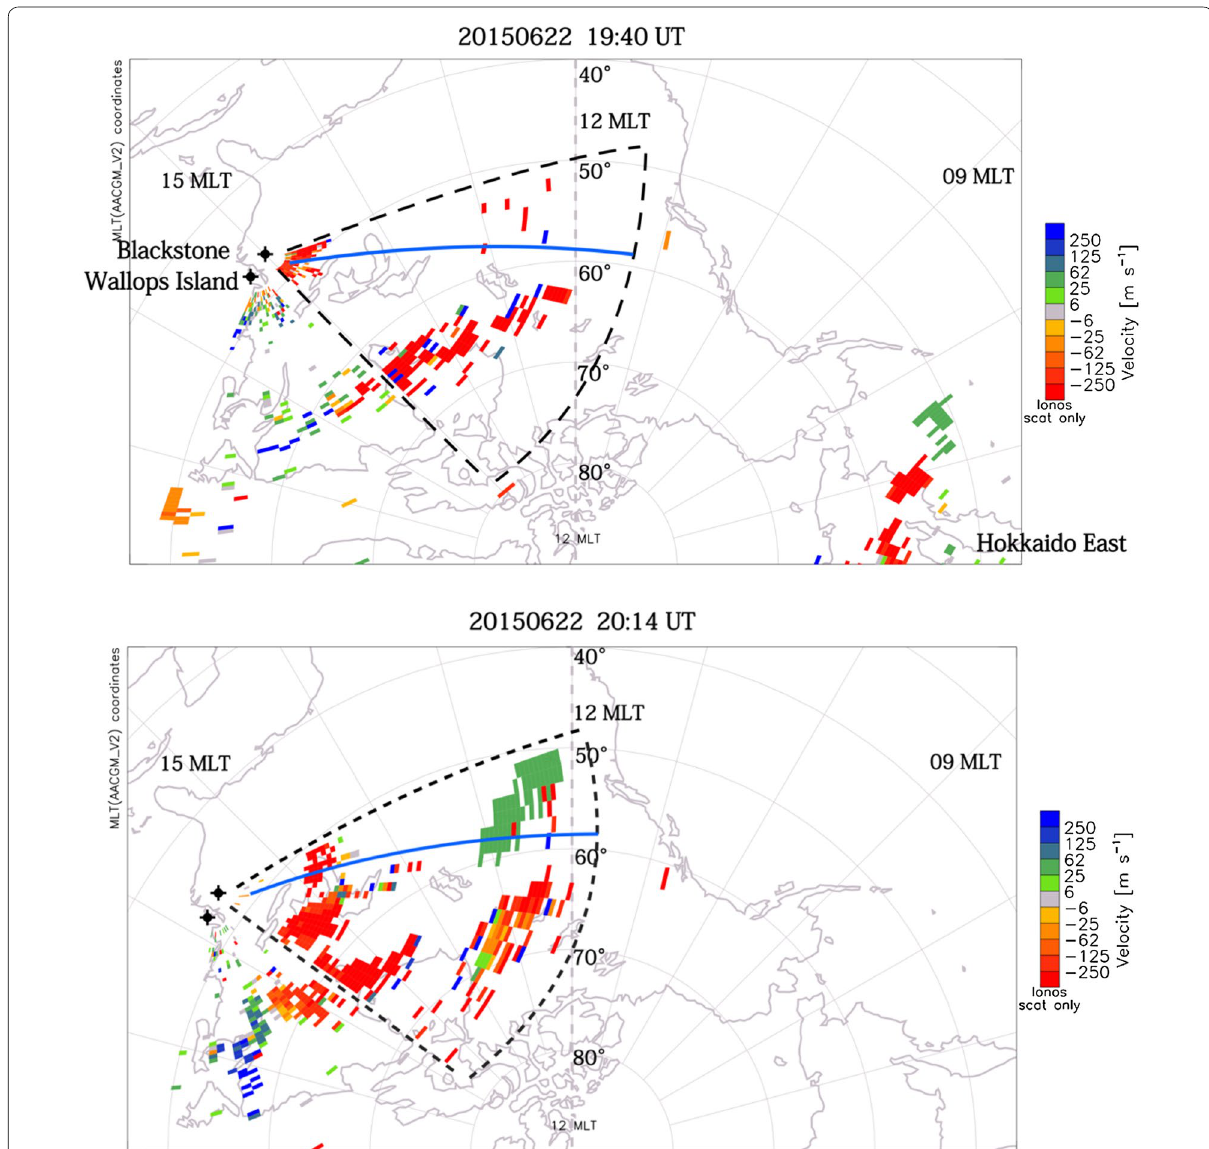
Fig. 6 Line of sight velocity map constructed with two SuperDARN radars in the northern America and two radars in Japan. The blue and green colors of the velocity refer to toward the radar and red refers to away from the radar. The radars detected the sunward (12 MLT to the top) flow (red) at 1940 UT during the storm main phase and anti-sunward flow (green) equatorward of the sunward flow at 2014 UT during the impulsive electric field